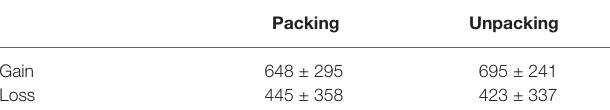
TABLE 3 | Subjective values of delayed choices in different conditions ( M ± SD